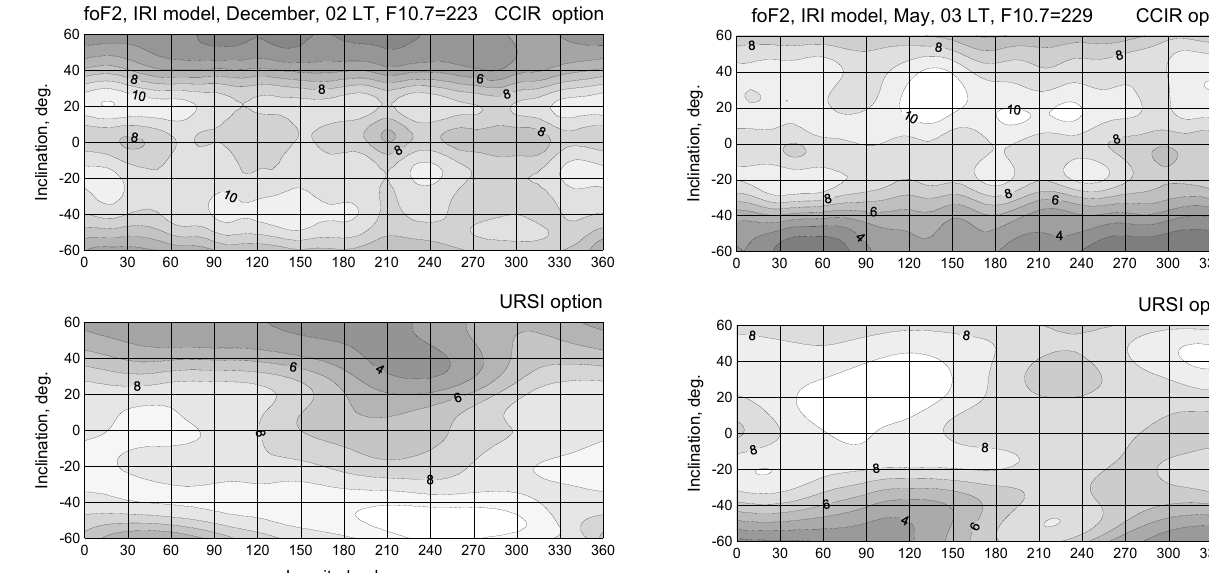
foF2, IRI model, December, 02 LT, F10.7=223 CCIR option